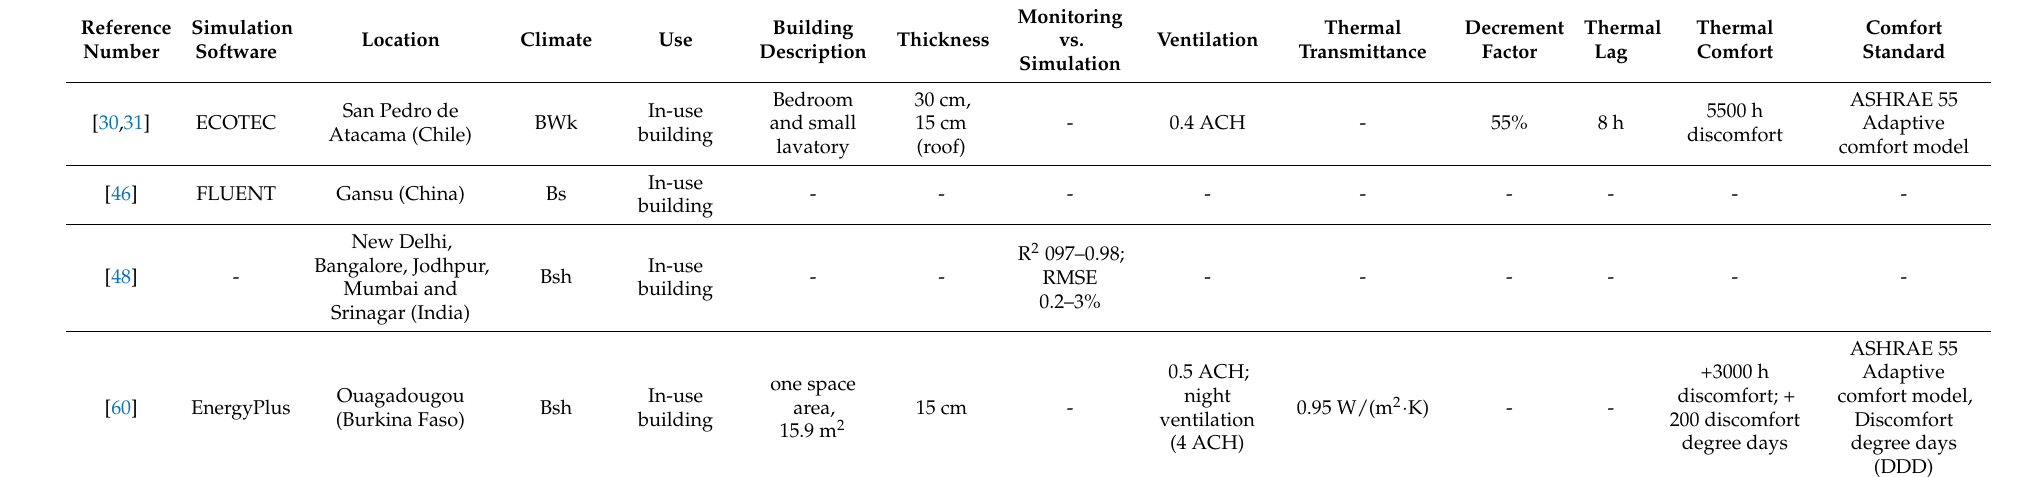
Table 12. Building characteristics and thermal performance of the adobe simulated studies.